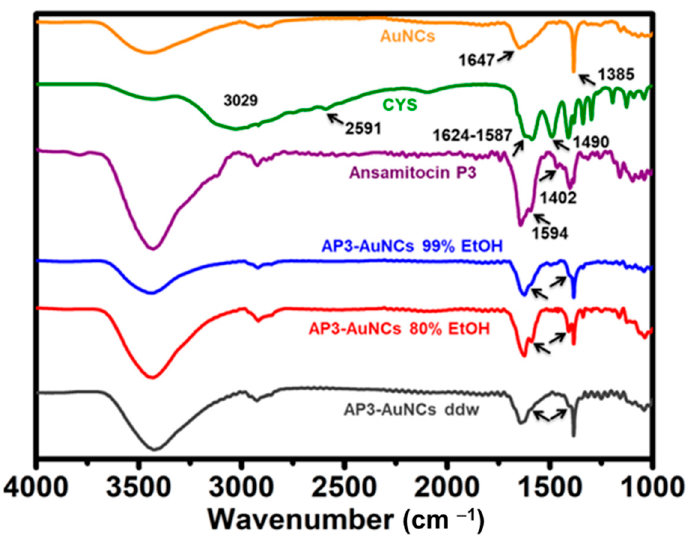
Figure 2. Fourier transform infrared spectra (FTIR) of AuNCs, CYS, AP3, AP3-AuNCs in ddw, 80% EtOH and 99% EtOH.